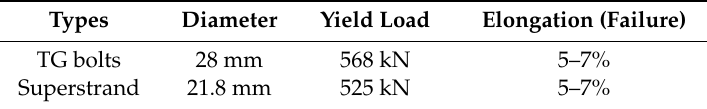
Figure 3. ( a ) Superstrand with indented wires, and ( b ) Superstrand with plain wires. Table 1. Mechanical properties of Superstrand and TG